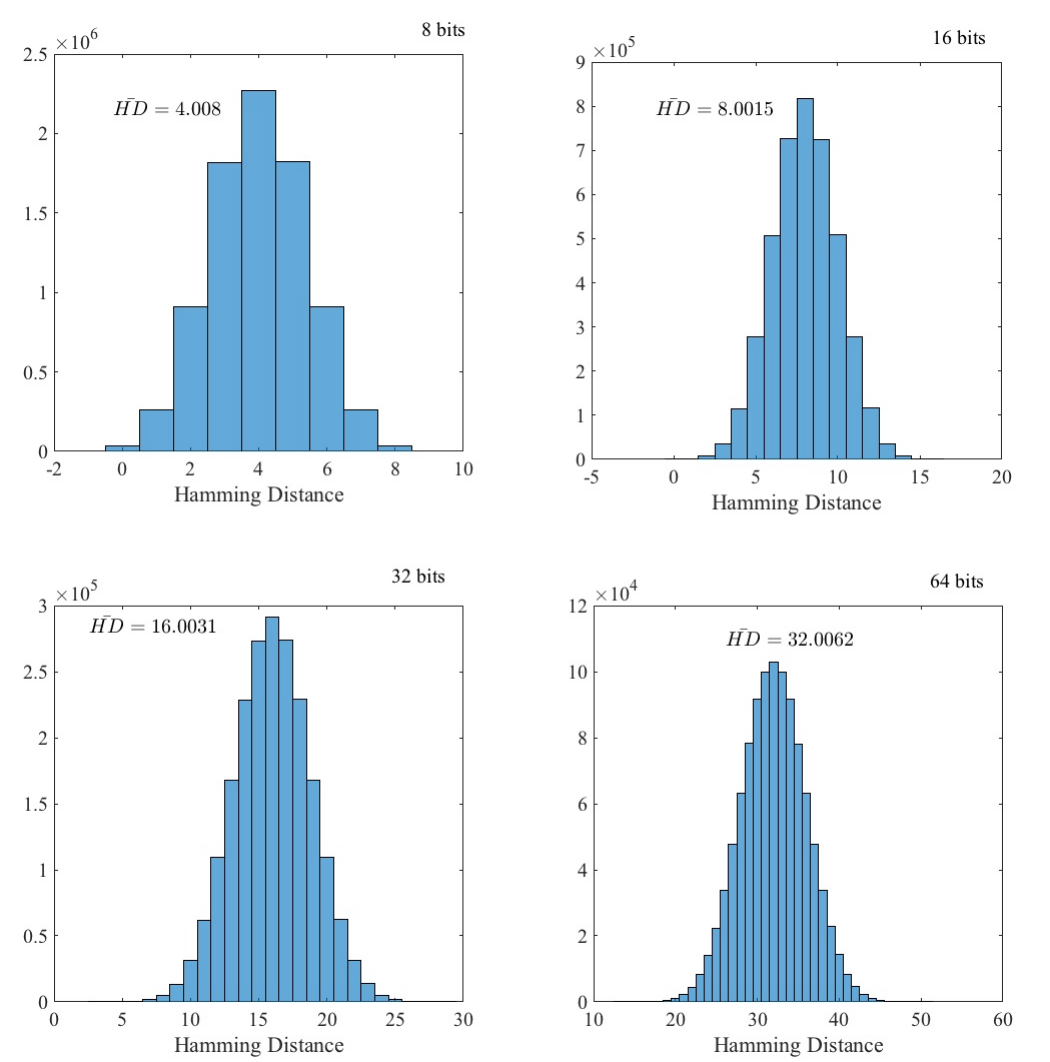
Figure 5. Hamming distance